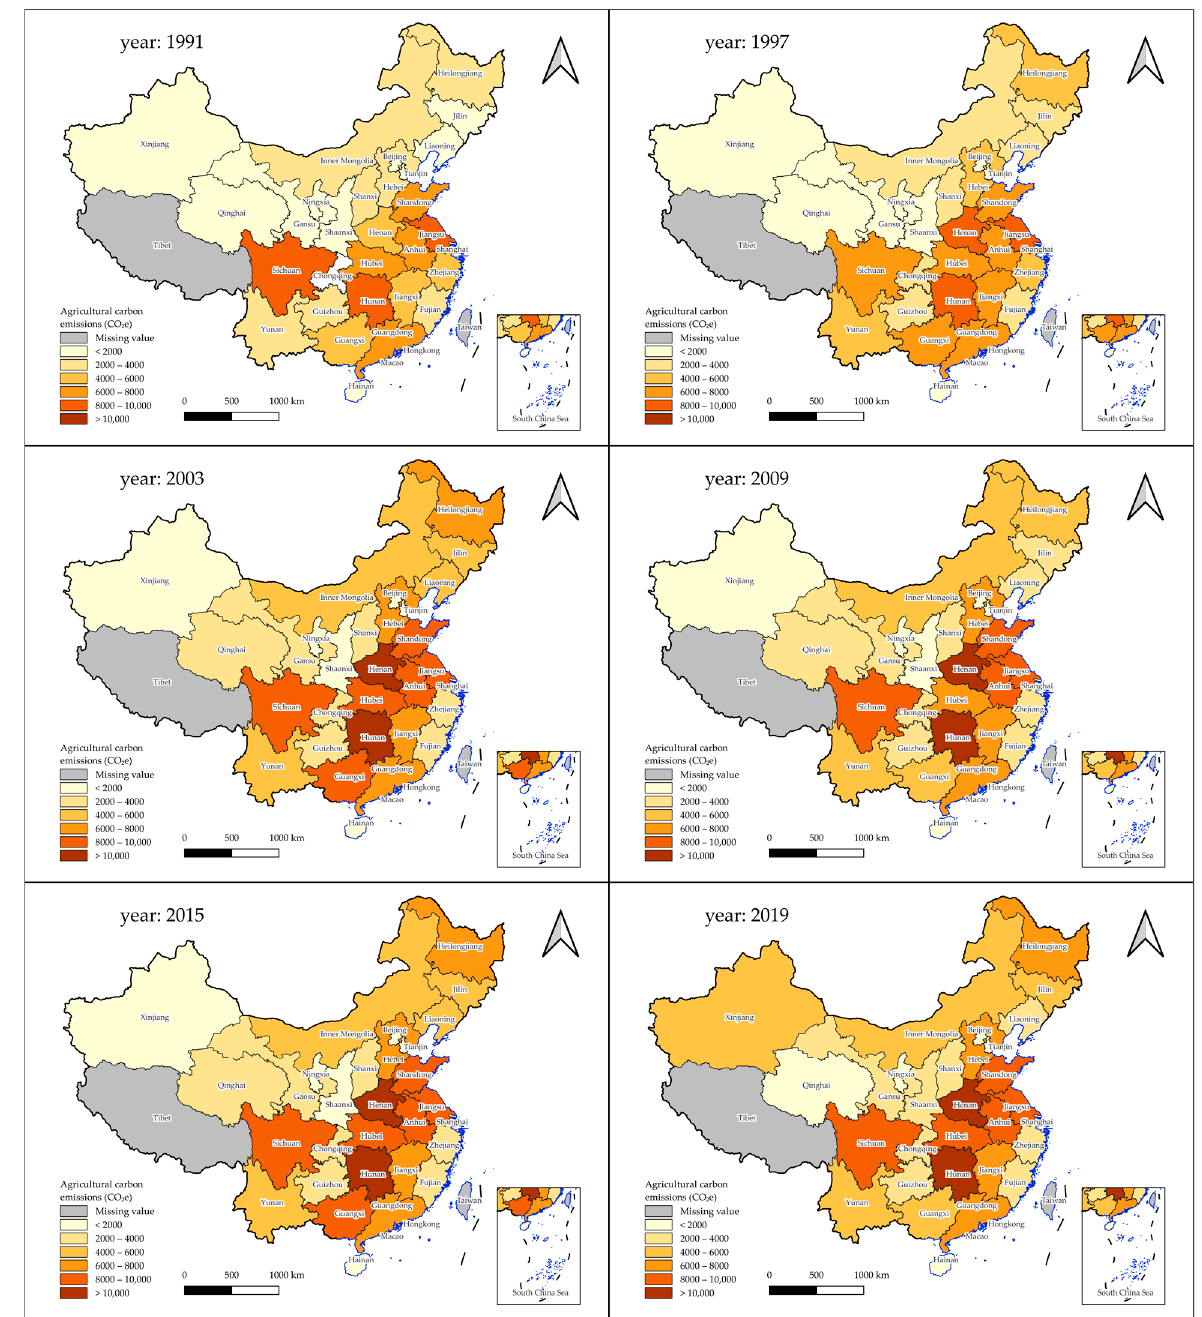
Figure 3. The spatial distribution of China’s agricultural carbon emissions.